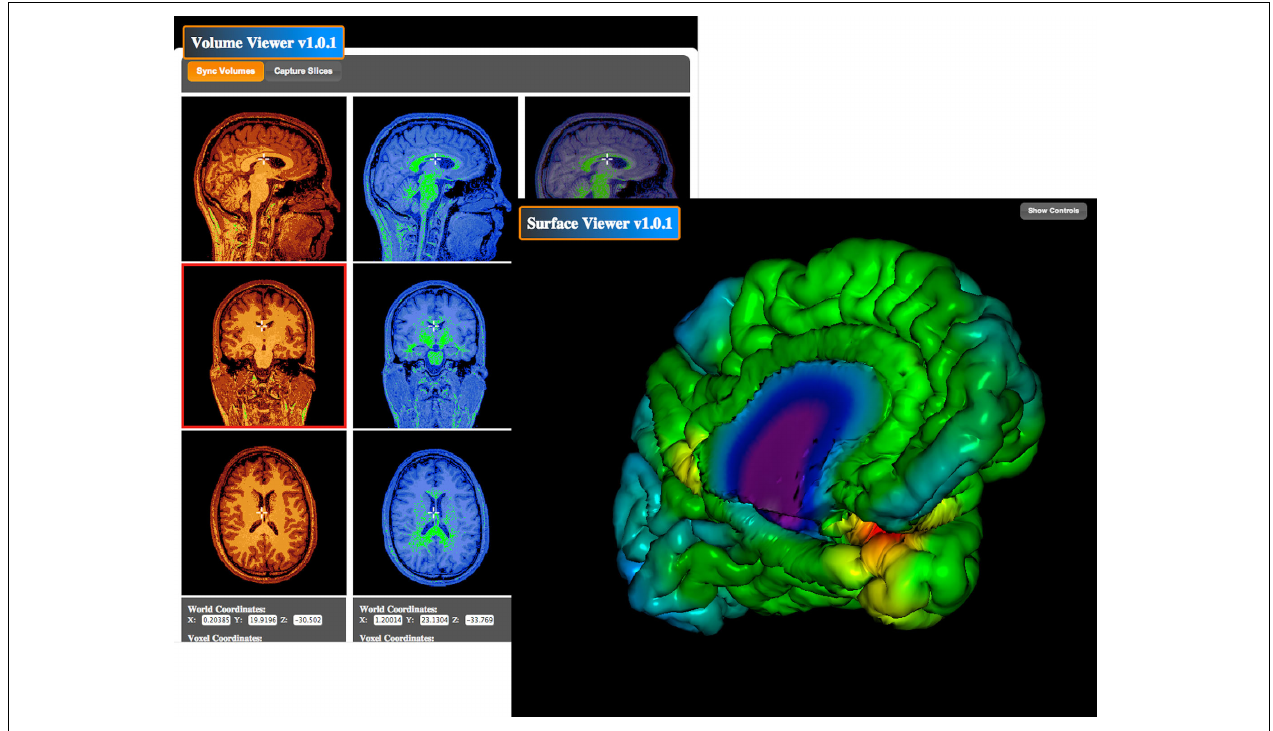
FIGURE 7 | BrainBrowser Surface and Volume Viewers. BrainBrowser allows CBRAIN users to examine any MINC file volume or 3D object (such as surfaces from CIVET, Freesurfer, or Wavefront objects) directly within their